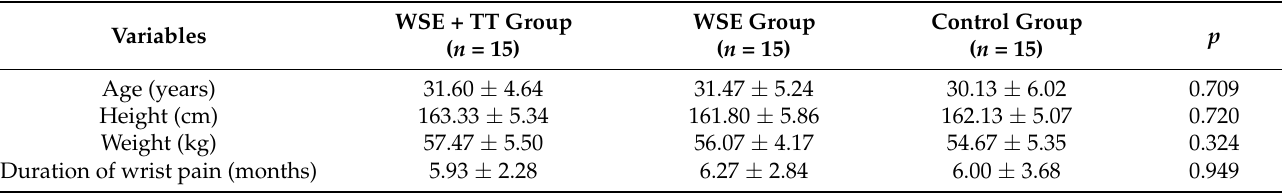
Table 1. Common and clinical characteristics of the subjects ( n =